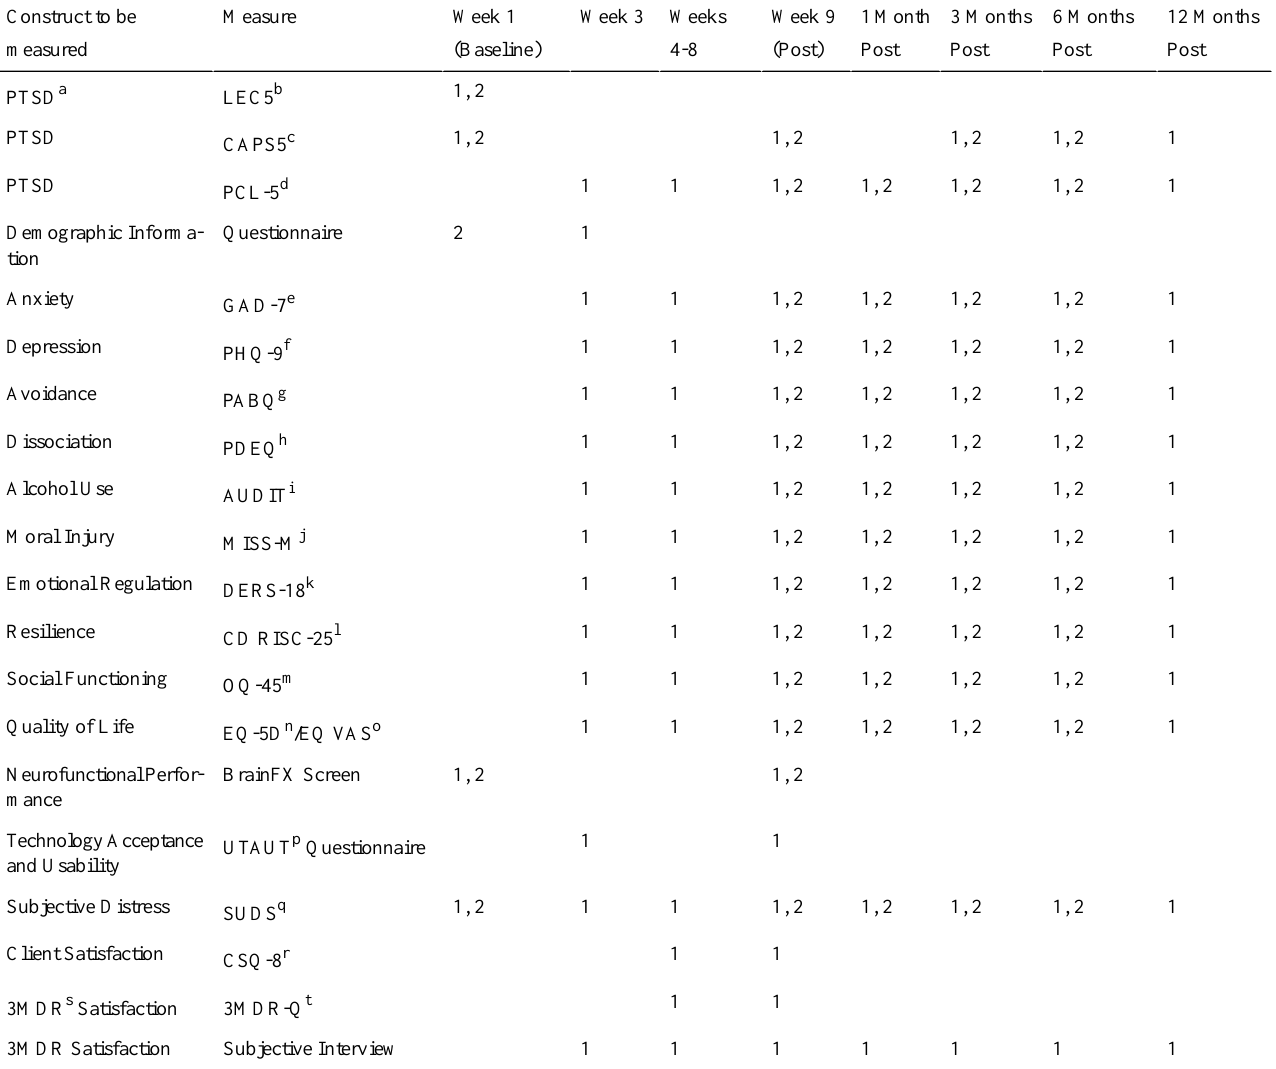
Table 1. Time points of data collection for participants in the intervention group (1) and control group